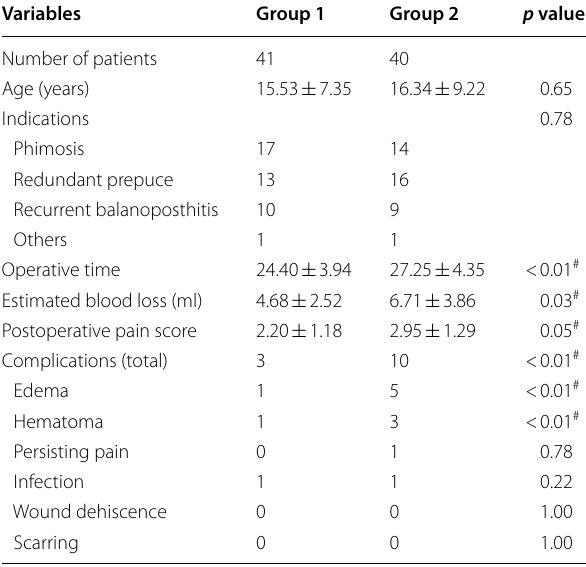
Table 1 Comparison of clinical data for Holmium YAG